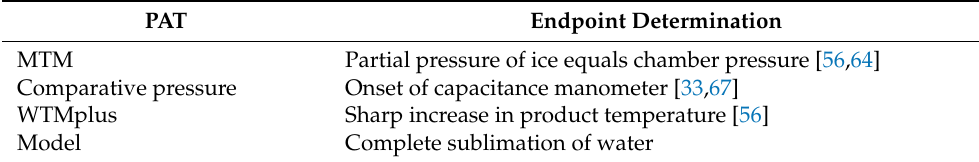
Table 4. Endpoint determination for different PATs.